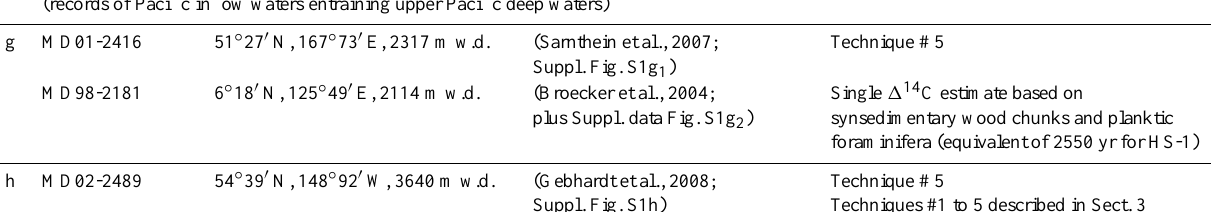
Table 1b. List of core locations (compare Fig. 7) and techniques #1–5 used to obtain benthic ventilation ages and shortly explained in the Methods Section 3, as well as published data sources. Ventilation ages derived by technique #5 (Fig. S1) were generated on the basis of 14 C plateau boundary ages identified in the new ’Suigetsu’ atmospheric 1 14 C record (Bronk Ramsey et al., 2012). Apparent ventilation ages and data sources listed in Table 1 and Fig. 7 are deposited in the PANGAEA databank (http://www.pangaea.de/PangaVista)